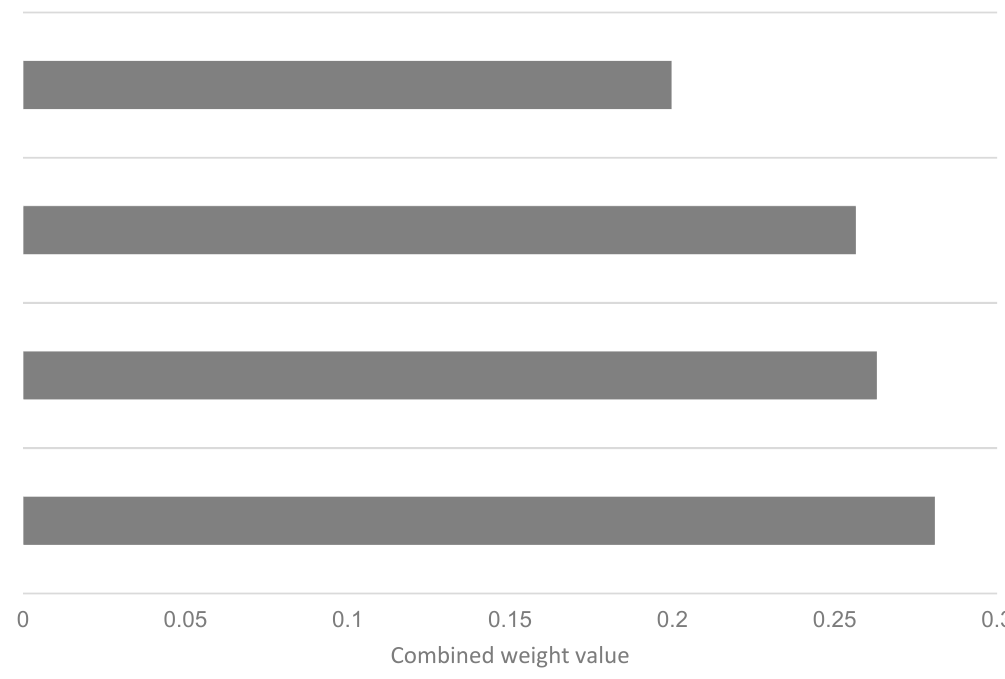
Figure 3. Statistical comprehensive weight values of scheme layer. 5. Discussion First, PU had the most notable effect on the adult use of fitness apps. The indicators we used to measure B1 (PU) were the pair of H1 (content adaptability) and H2 (content relevance), as well as H3 (content quality). Among them, H1 was the influencing factor with the highest weight because the users of fitness apps are of different ages and have